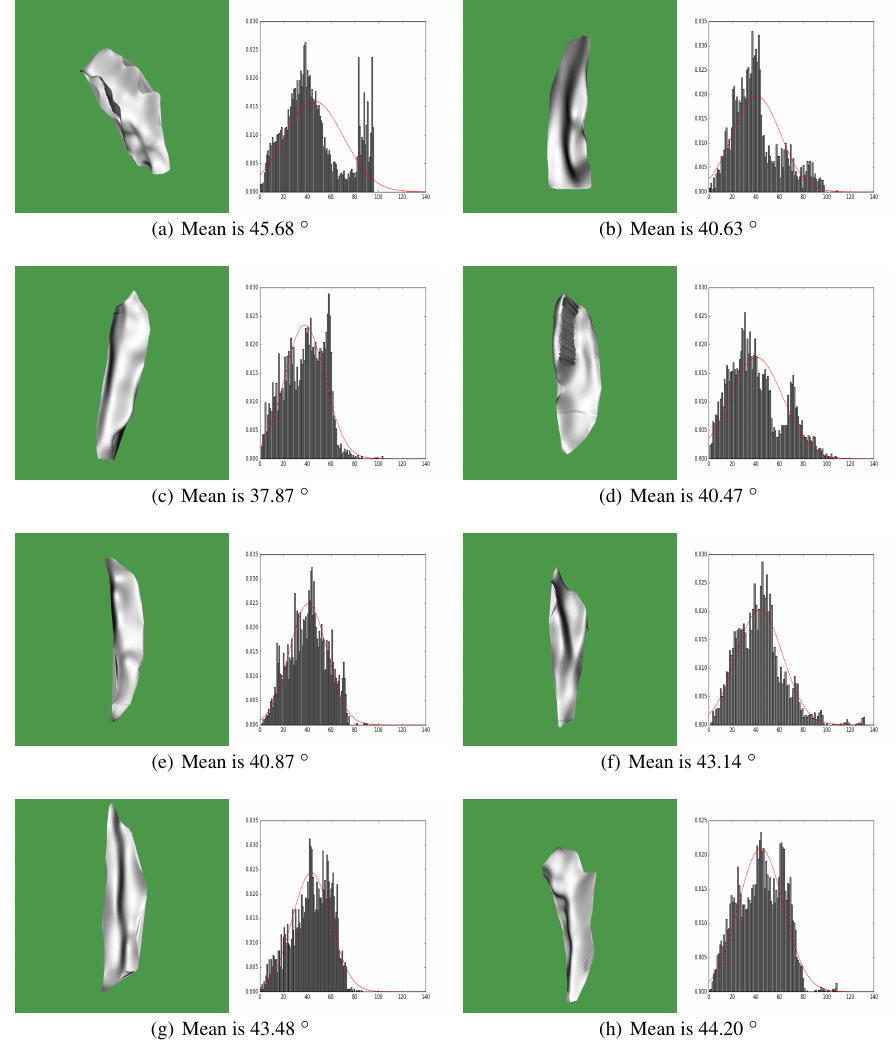
Figure 6. The included angle statistics of 8 curled